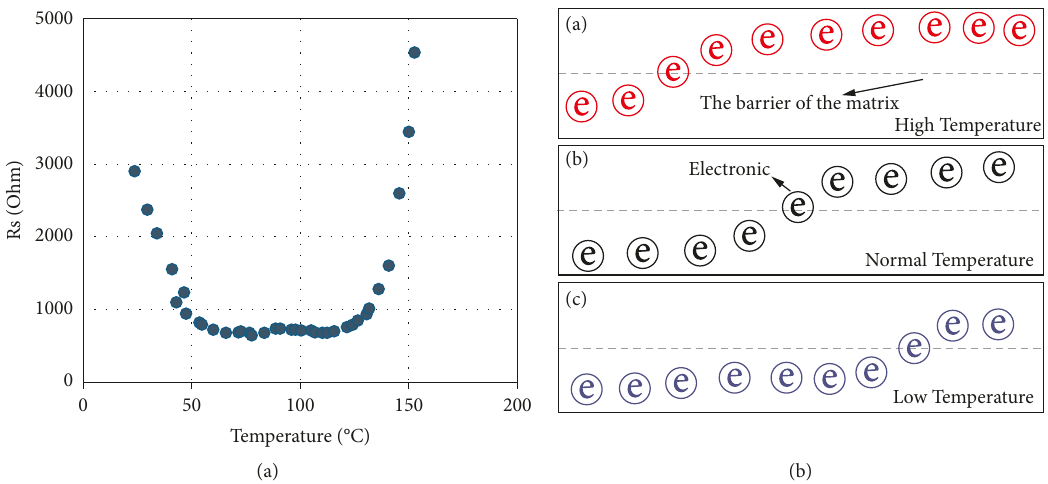
Figure 8: (a) The variation of electrical resistance with temperature in the Rs extension range. (b) Schematic diagram of overcoming potential barrier by electron excitation at different temperatures of CFRP